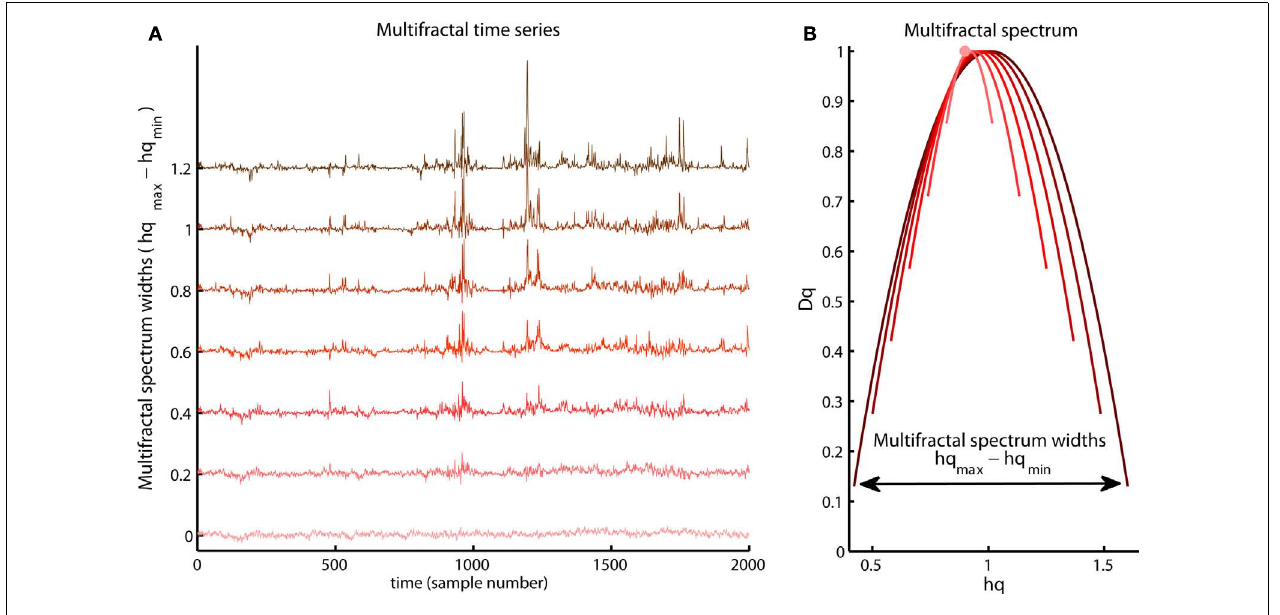
arrow in the (B)]. Notice the growth of structural differences between the periods with small and large fluctuations as the multifractal spectrum width become larger.